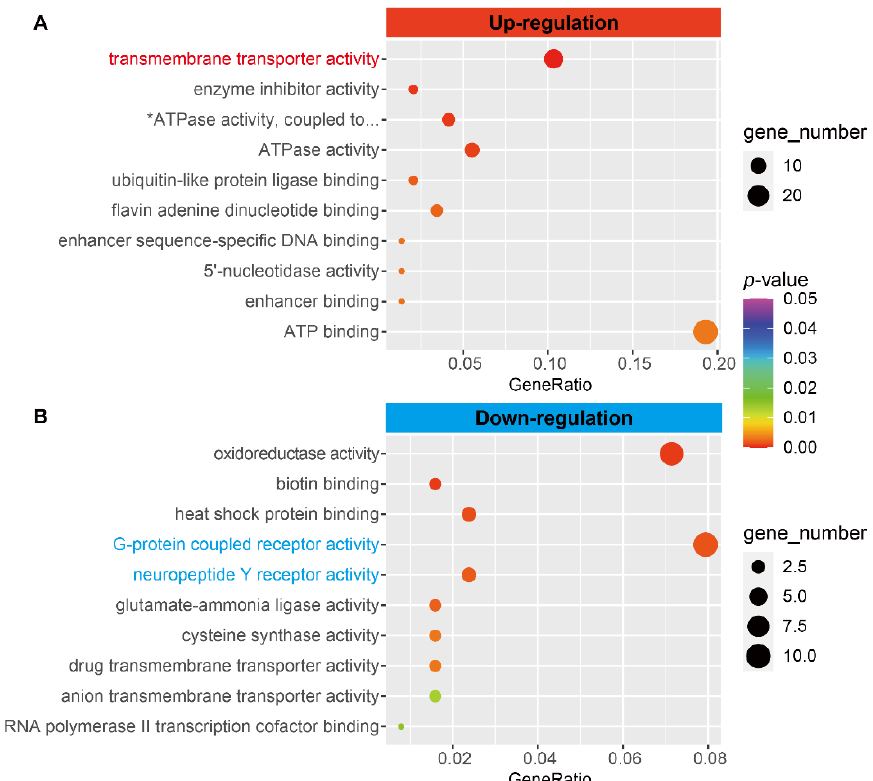
Figure 4. GO-MF (molecular function) enrichment analysis for DEGs. ( A ) The top 10 enriched GO-MF terms for upregulated DEGs. * The full name of this term is “ATPase activity, coupled to transmembrane movement of substances”. ( B ) The top 10 enriched GO-MF terms for downregulated DEGs. Significance of enrichment is indicated by color from red to purple. Gene ratio is the ratio of the number of DEGs annotated to the GO term to the total number of DEGs.